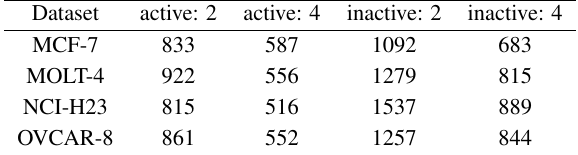
Table 8 MRFSM [25] performance analysis on biological graphs (time in seconds, threshold frequency: 50%).